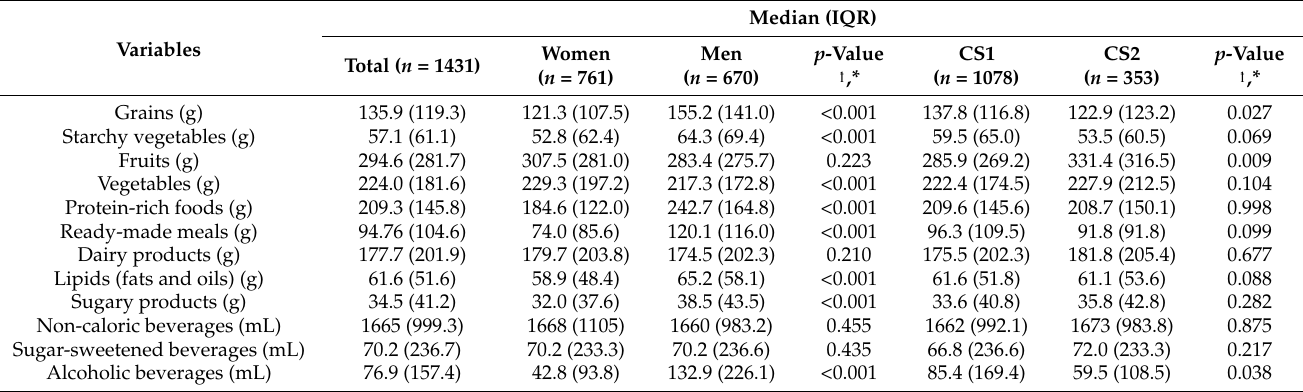
Table 3. Distribution (median and IQR) of food group consumption per day according to gender and constipation score groups.